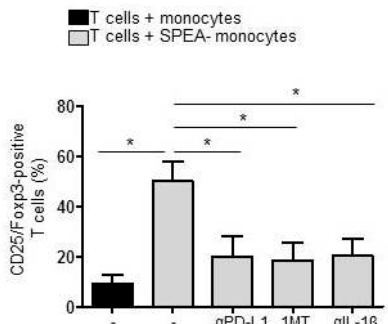
Figure 7. Accumulation of Tregs in SPEA-monocyte / T-cell coculture depends on PD-L1 and IDO. Monocytes were stimulated with SPEA for 48 h or left unstimulated. Additionally, cells were treated with 1MT (240 µ M, 1 h prior to SPEA stimulation) or anti-IL-1 β antibody (3 µ g / mL during stimulation). After two days, cells were washed, anti-PD-L1 antibody (10 µ g / mL) was supplemented when indicated in the graph, and allogeneic CD3 / CD28-activated CD4 T cells (ratio 1:2) were added. After five days, cells were stained with fluorescent anti-CD25 and anti-Foxp3 antibodies and analyzed on a FACSCanto. Shown is the percentage of CD25 / Foxp3-positive T cells in the T-cell population. Black columns: T cells cultured with unstimulated monocytes. Grey columns: T cells cultured with SPEA-monocytes, treated as indicated. Columns depict the mean + SD (error bars) of four experiments. Statistical analysis: Mann–Whitney U test with * p ≤ 0.05. The line above the columns depicts the compared groups. Kruskal–Wallis: number of groups: 5; p -value 0.0130; sum value, * the medians vary significantly ( p < 0.05).